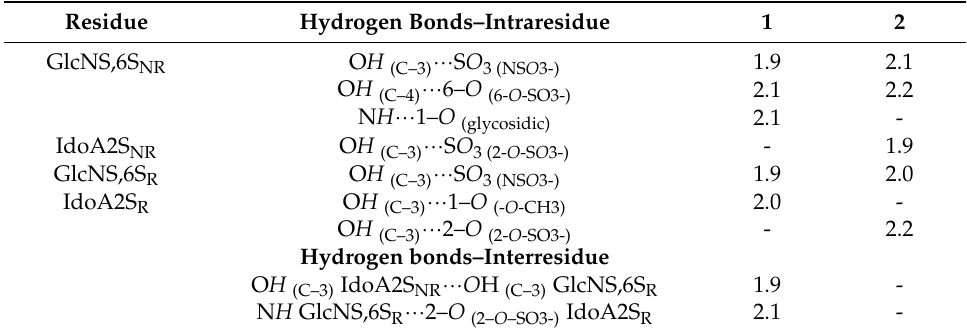
Figure 3. Intramolecular hydrogen bonds in 1 . One interresidue hydrogen bond is between the OH group at C–3 in the IdoA2S ring and the OH group at C–3 and the neighbouring reducing-end GlcNS,6S R residue (computed distance 1.88 Å). ( a ) Second interresidue hydrogen bond (2.14 Å) is between the NH group (GlcNS,6S R ) and O–2 (2–O–SO 3 − group) in the IdoA2S R . ( b ). The other two H-bonds shown in ( a ) and ( b ) are intraresidue. Table 3. Intraresidue and interresidue hydrogen bonds in forms 1 and 2 of the heparin tetrasaccharide. Atoms involved in hydrogen bonds are in italics; distances are in Å.